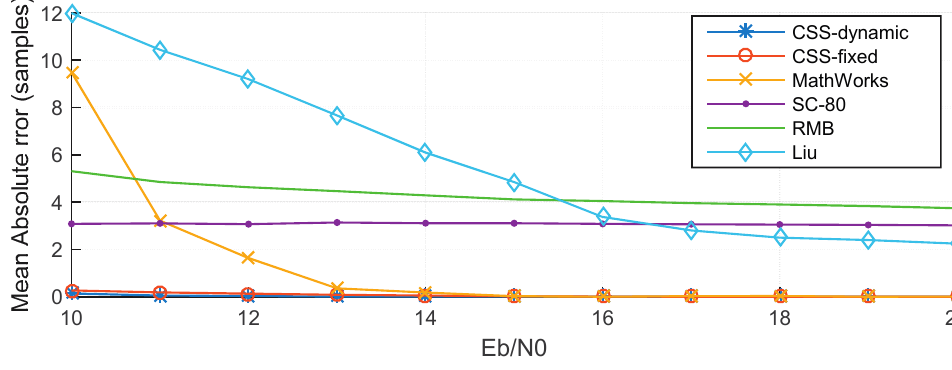
Figure 14. MAE of different methods with E b /N 0 > 10